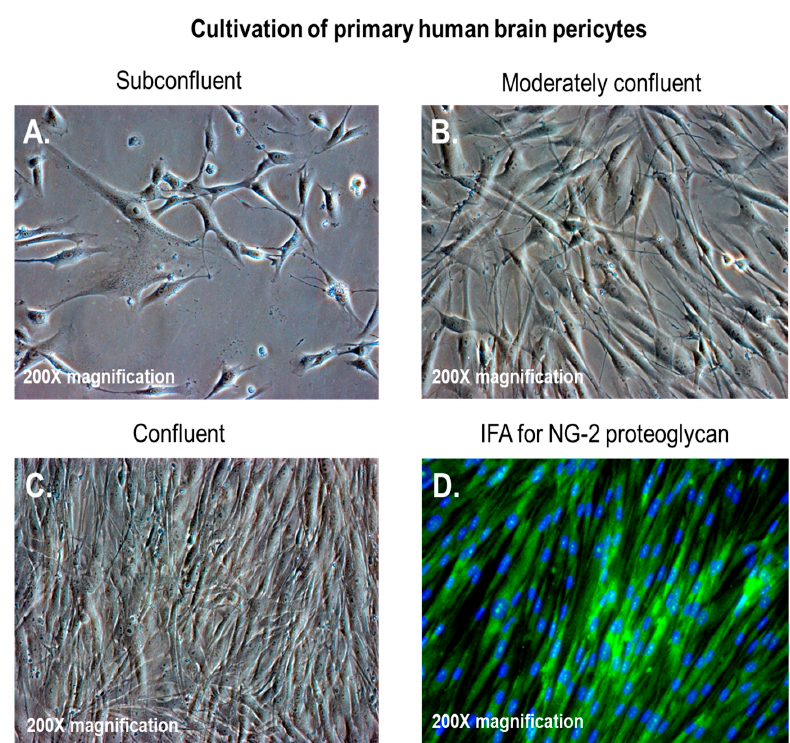
Figure 1. Brain vascular pericytes in vitro. ( A – C ) Primary human brain pericytes in culture, from low to high confluency; ( D ) primary human brain pericytes stained with a monoclonal antibody against neural/glial antigen-2 (NG2) proteoglycan. The total magnification is 200× ([17], Figure 1A, C). J. Clin. Med. 2020 , 9 , x FOR PEER REVIEW